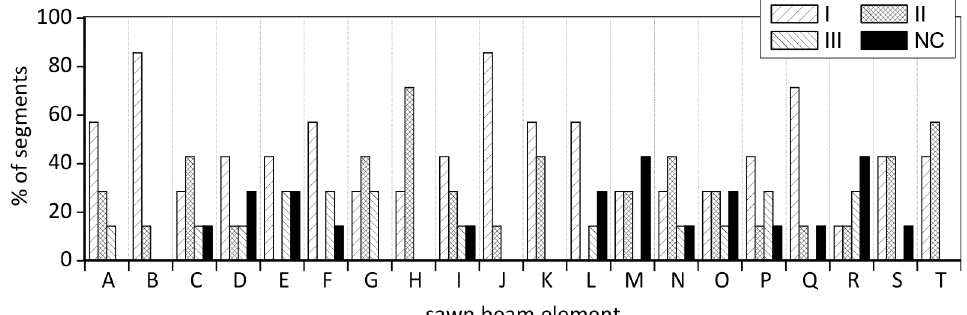
Fig. 5. Percentage distribution of segments included in each visual grading class according to UNI 11119:2004 for sawn